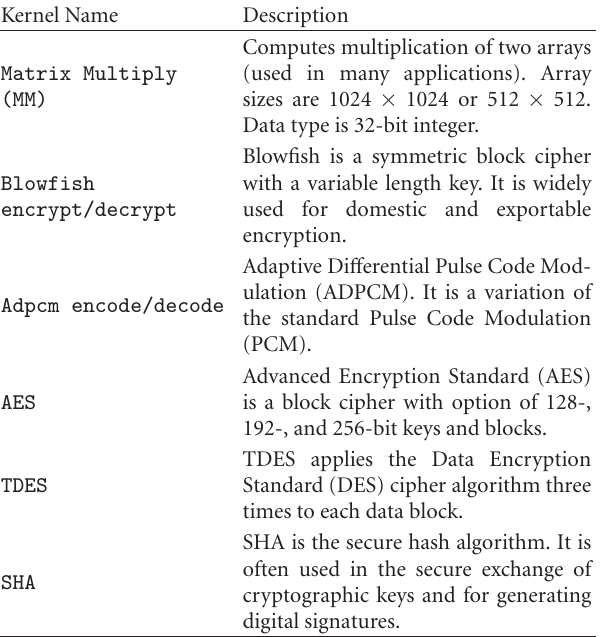
Table 5: Kernel characteristics.